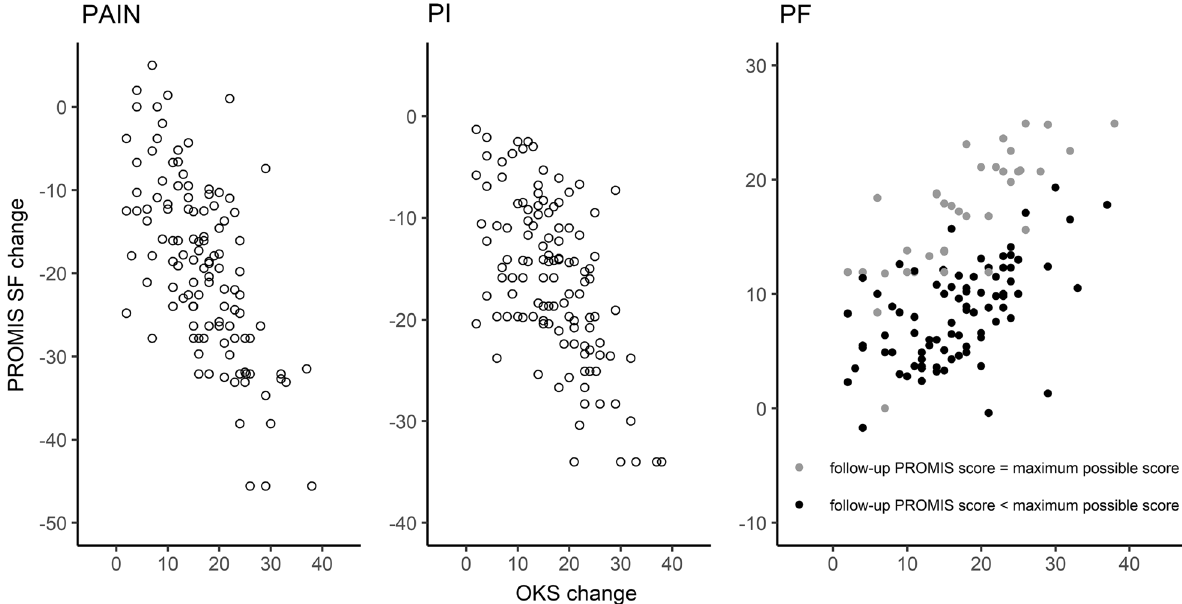
Fig. 2 Responsiveness plots for PAIN, PI and PF with the latter highlighting if the patient achieved the best possible score or